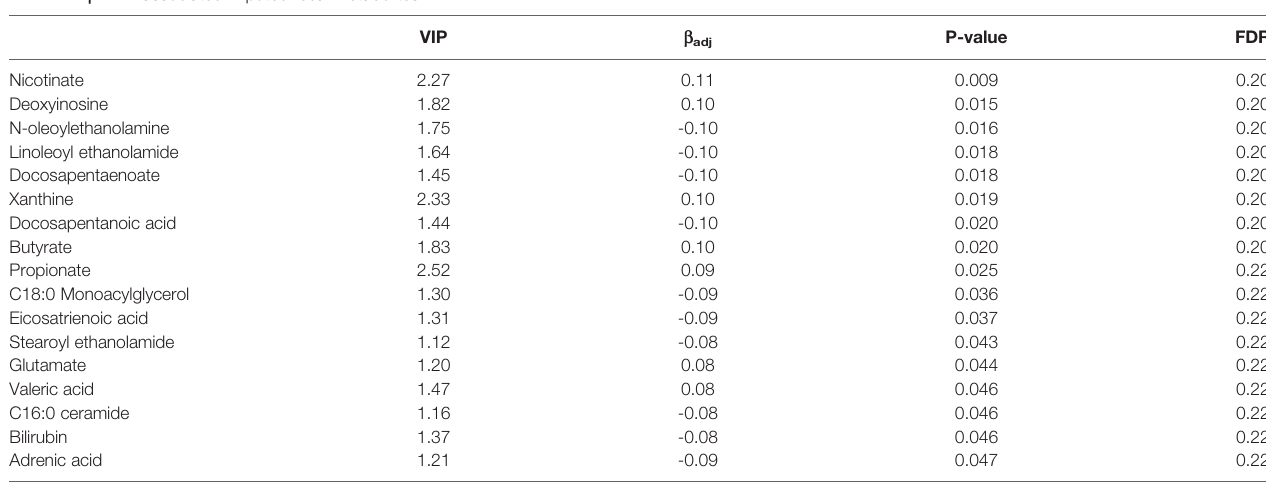
TABLE 4 | BMD associated imputed fecal